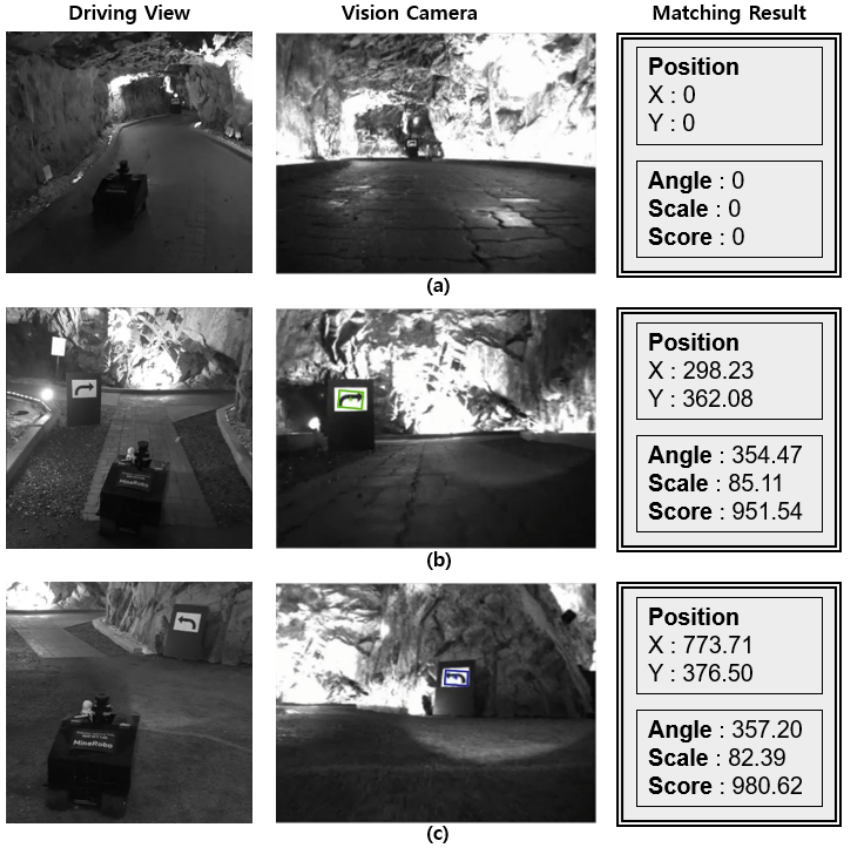
Figure 6. Field experimental scenes, view of vision camera and matching results of the autonomous driving robot in ( a ) the straight section, ( b ) the right turn section, and ( c ) the left turn section.